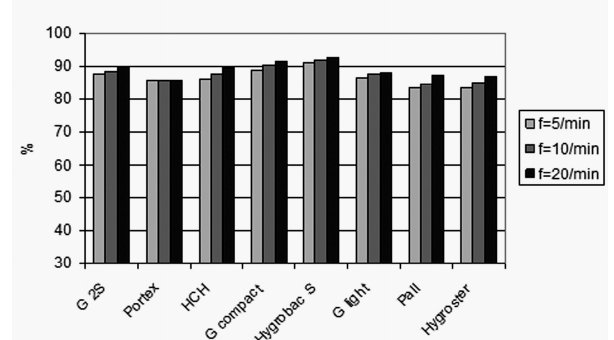
Figure 3 - Effect of respiratory frequency (5, 10 and 20/min) with chang- ing %RAH. The %RAH did not depend on frequency. Again, differences in %RAH between HME were minimal.